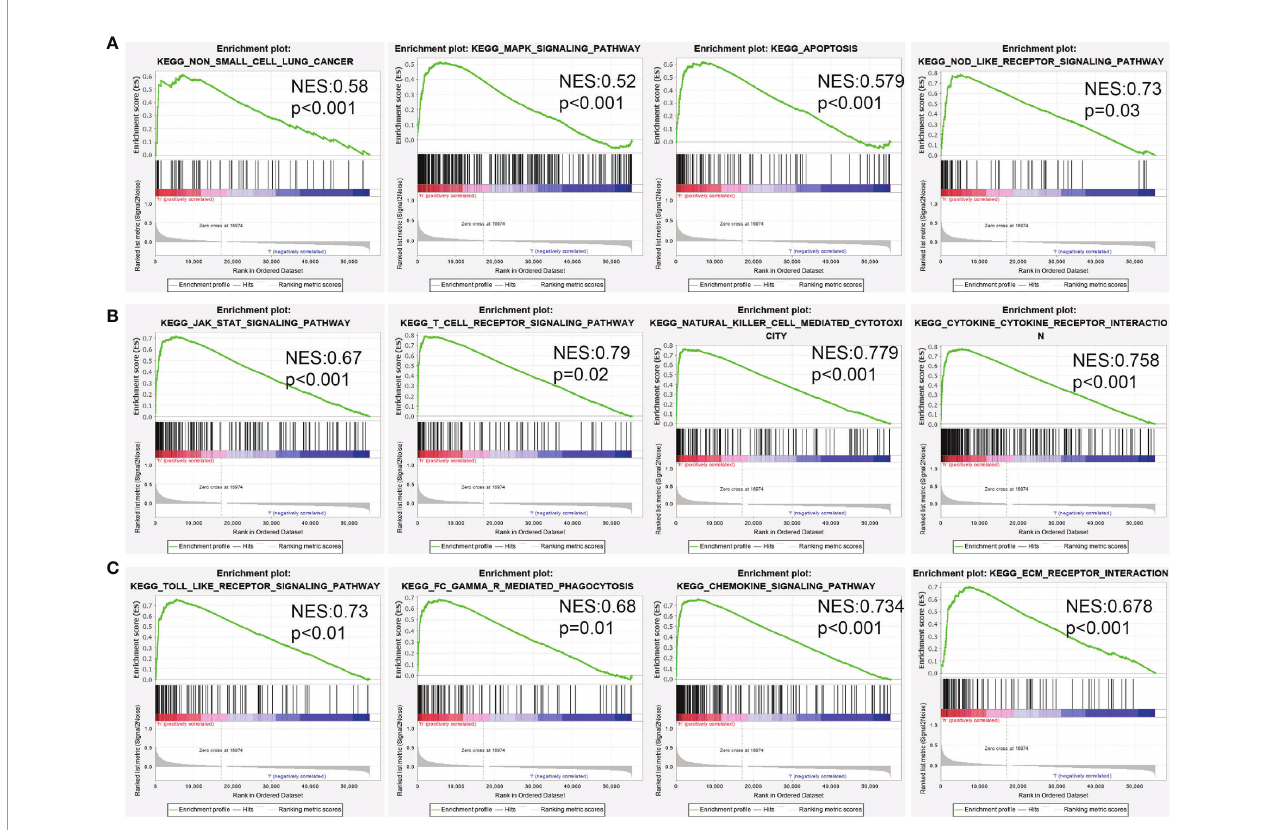
FIGURE 4 | Analysis of the signaling pathway for miRNA-30a-5p target genes in human cancers. (A – C) The potential signaling pathway of miRNA-30a-5p target gene analysed using GSEA